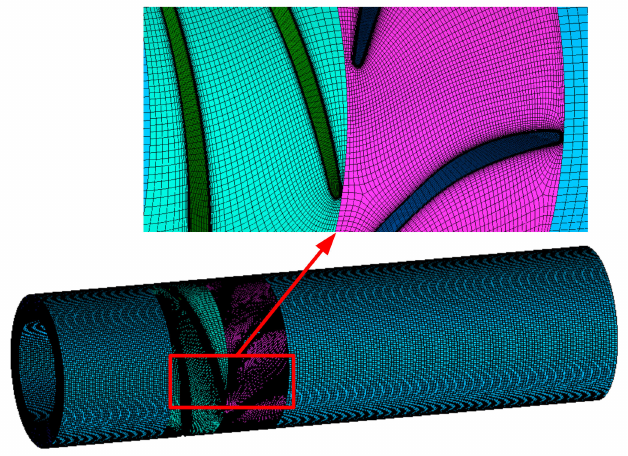
Figure 4. Fluid domain